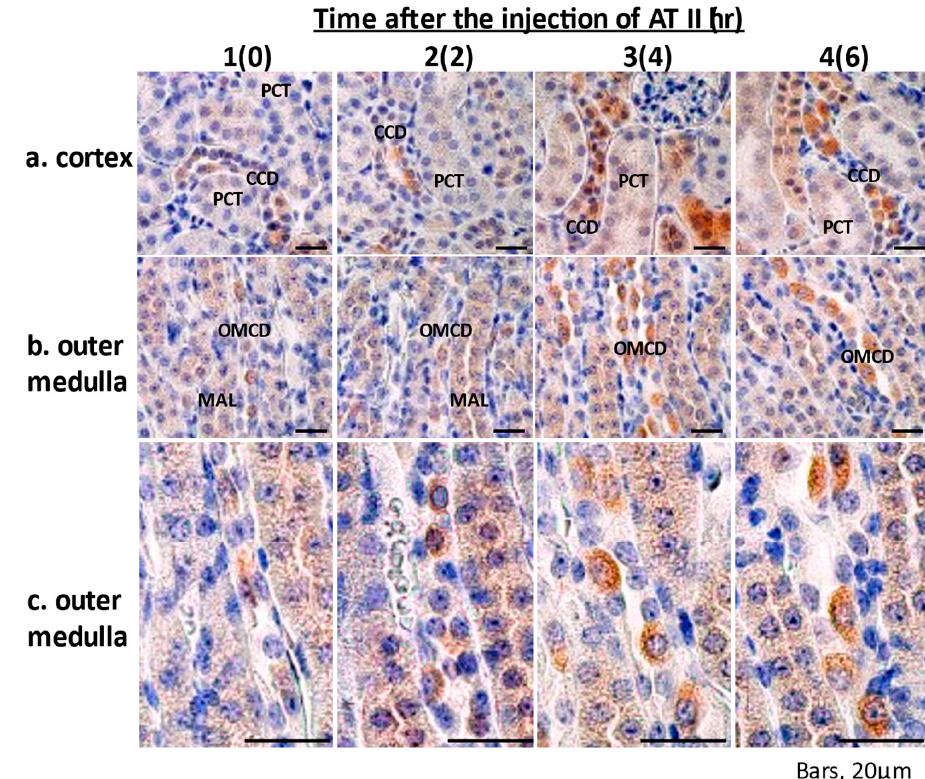
Figure 4. Immunohistochemical study of the effects of ATII on Epo production by the kidney. Under basal conditions, Epo staining was found from the proximal tubules to the collecting ducts (proximal tubules < thick ascending limbs < collecting ducts) (1- a – c ). ATII increased Epo production in MAL, CCD, and OMCD (3~4- a – c ), particularly in the type A intercalated cells, after 4–6 h (brown cells in 3~4- a – c ). The renal outer medulla is shown at a different magnification. The numbers 1, 2, 3, and 4 show 0, 2, 4, and 6 h after the injection of ATII,